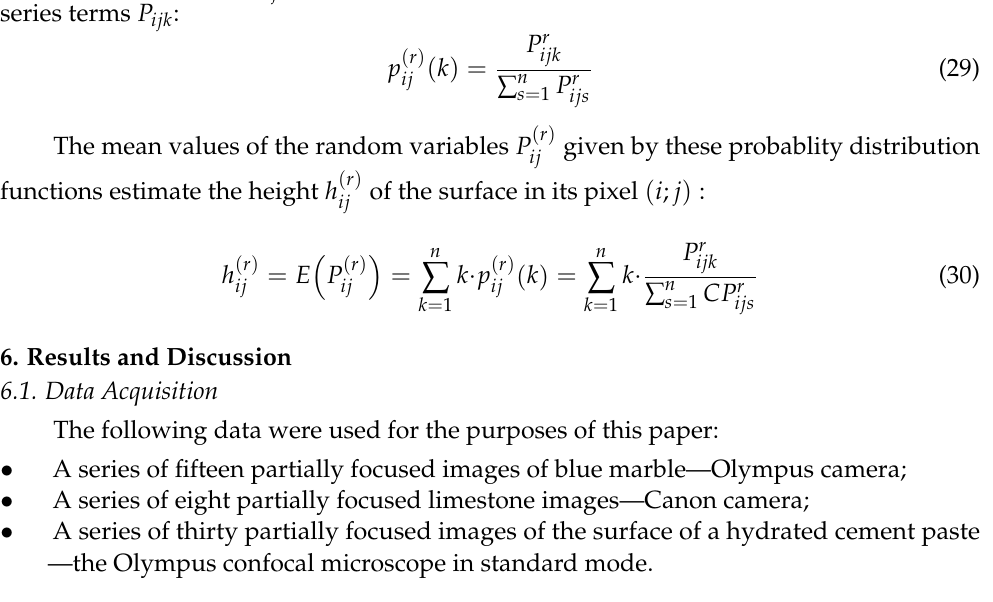
a P ( a ); b P ( b ); c P ( c ). Taken from